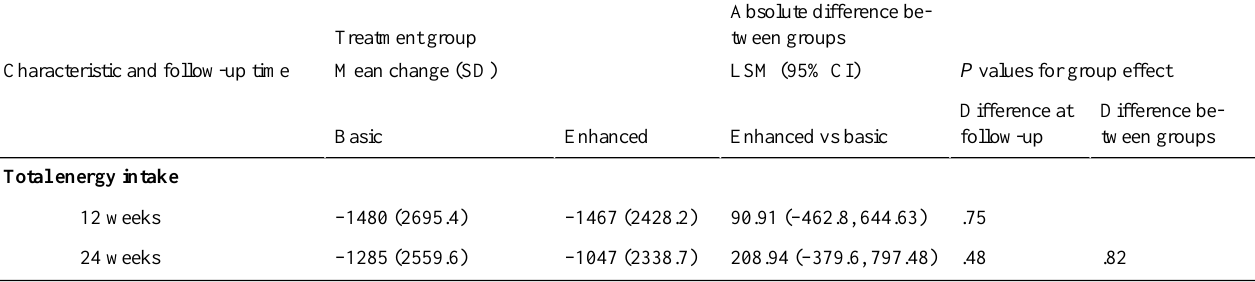
Table 6. Mean change in total website usage for the completers population and the ITT with LOCF from baseline to 12 weeks and baseline to 24 weeks within each treatment group.